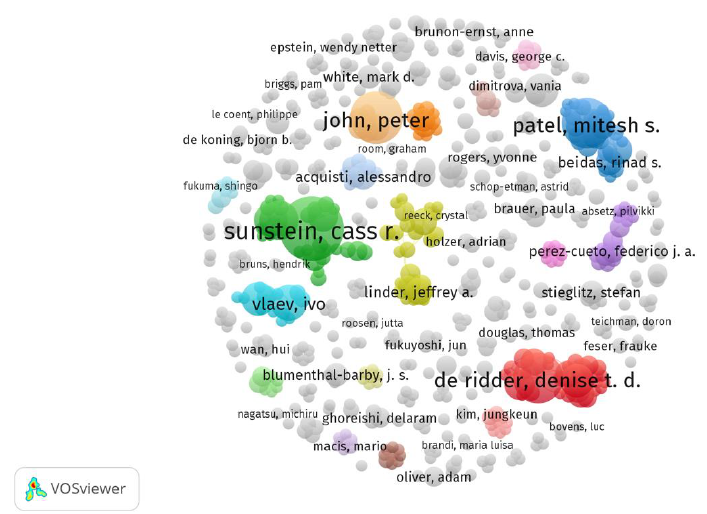
Figure 7. Network visualization for co-authorship analysis.